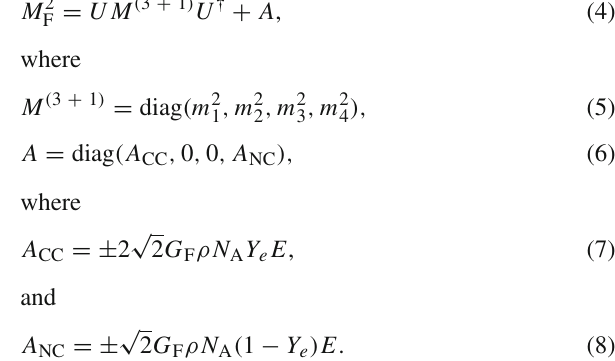
Fig. 1 Comparison of the survival probability for neutrinos ( left-hand panels ) and anti-neutrinos ( right-hand panels ) for 3 ( black line ) and 3 + 1 ( red line ) generations, as a function of (anti)neutrino energy. The top panels are for cos θ ν z = 1 . 0 (down-going neutrinos, L = 15km), while the bottom panels are for cos θ ν z = − 1 . 0 (up-coming neutri-